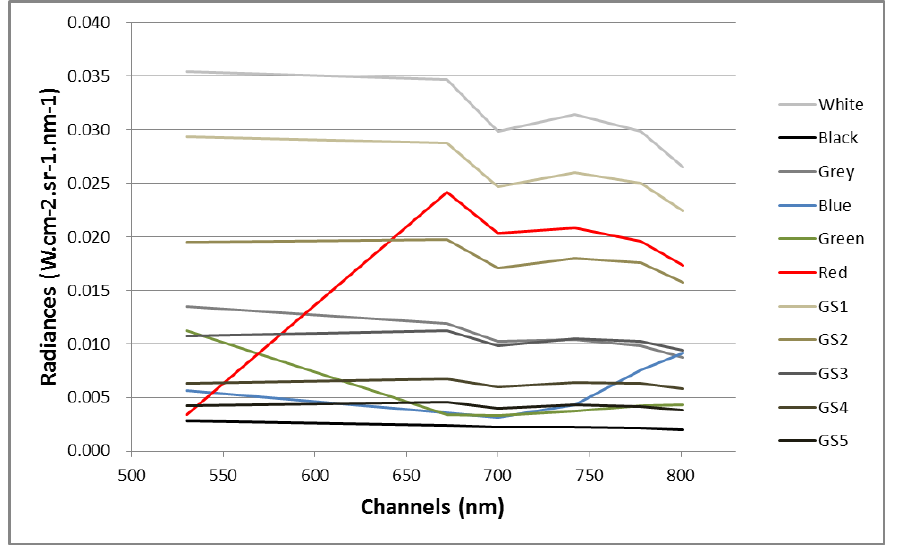
Figure 11. Average radiance for artificial targets. GS, greyscale